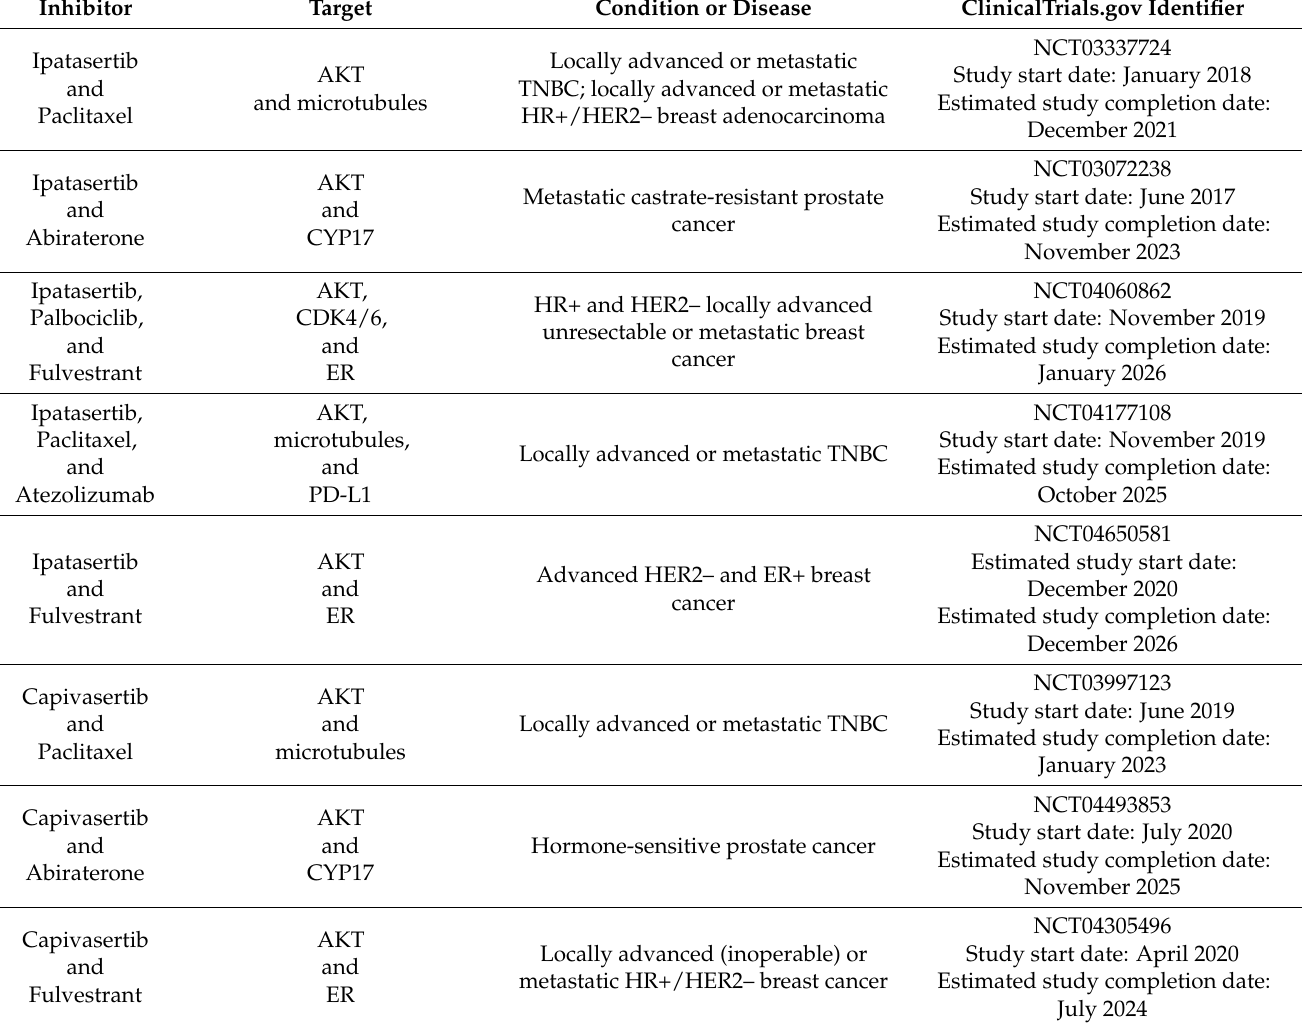
Table 6. AKT inhibitors in phase III clinical trials 1